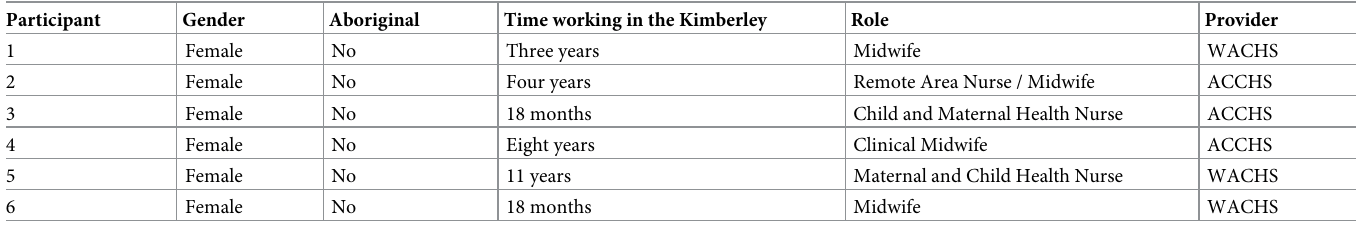
Table 2. Characteristics of healthcare professionals interviewed for the KMMS implementation acceptability